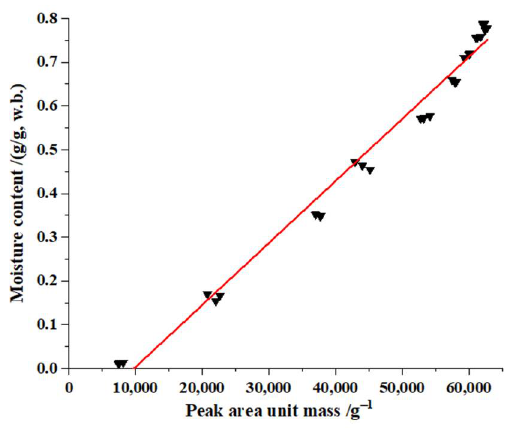
Figure 7. Fitting curve between the peak area unit mass and moisture content.